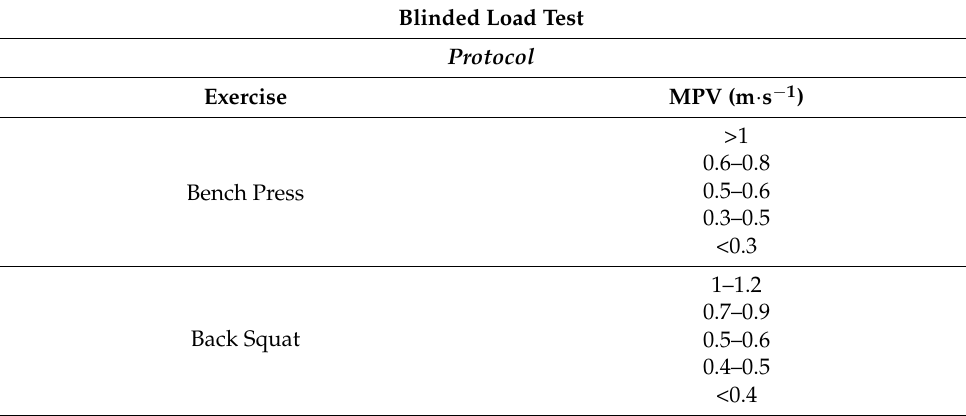
Table 3. Intensity intervals for the choice of loads in the PV assessment.